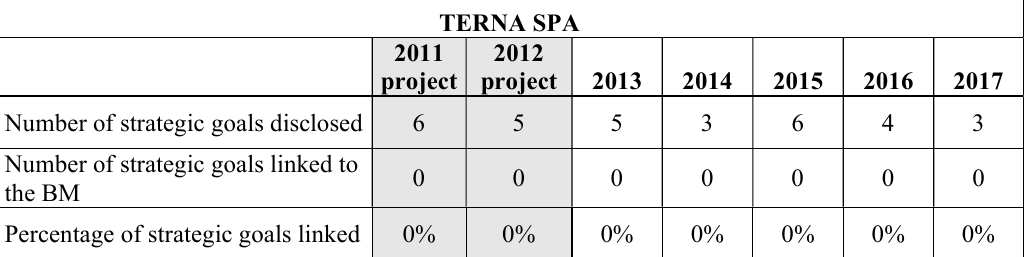
Table 3: Strategy-BM